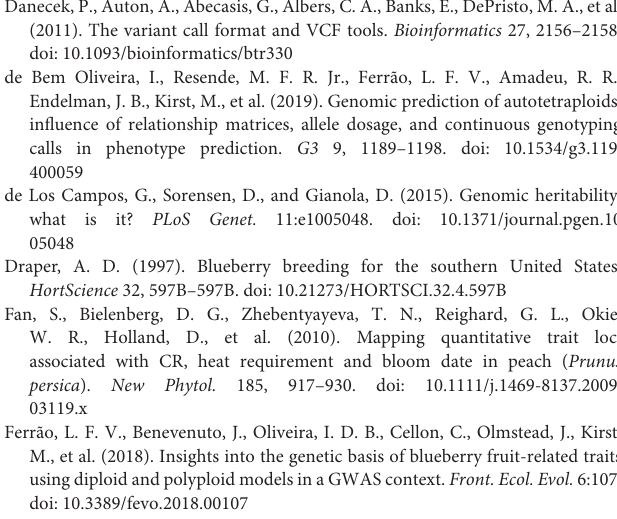
loci with the lowest value of p . Double asterisk ( ∗∗ ) represents the significant difference ( p < 0.01). Supplementary Figure 6 | Characterization of the associations with flowering date detected on chromosome 7. (A,B) Associations with the flowering date. (A) GWAS for the flowering date in (A) 2019 and (B) 2020 detected by GWASpoly reference duplex dominant model with SNP discrete genotype call. Red dots represent significant phenotype-genotype associations (FDR < 0.1). (C,D) Comparison of flowering date in (C) 2019 and (D) 2020 based on the genotypes at Chr7: 10849491. (E) Comparison of flowering date in 2018 based on the genotypes at Chr7: 10849505. Asterisks (*, **, and ***) represents the significant difference ( p < 0.05, p < 0.01, p < 0.001), respectively. (F) Pairwise allelic genotype correlation plot of Chr7: 10849491. Red and glean dots represent loci significantly associated with the flowering date in 2019 and 2020, and with flowering date in 2018, respectively. Red and green lines represent a cubic spline fitted for the 95th and 50th percentiles, respectively. Supplementary Figure 7 | Manhattan plot for FDP in 2019 season. GWAS results detected by GWASpoly reference duplex dominant model with SNP discrete genotype call. The red dot represents significant phenotype-genotype associations (FDR < 0.1). Supplementary Figure 8 | Differences of allele frequencies at loci significantly associated with phenology traits between NHB and SHB. Proportions of cultivar group at loci significantly associated with (A) flowering date in 2019 and 2020 (Chr3: 4052918), (B) continuous flowering (Chr5: 18699641), (C) flowering date in 2019 and 2020 (Chr7: 10849491), (D) FDP in 2018 (Chr9: 8401122), and (E) flowering date in 2018 (Chr9: 8490641). Supplementary Figure 9 | Differences of phenology-related allele frequencies among breeding locations. The proportion of genotype at loci significantly associated with (A) flowering date in 2019 and 2020 (Chr3: 4052918), (B) continuous flowering (Chr5: 18699641), and (C) flowering date in 2018 (Chr9: 8490641). Supplementary Figure 10 | Comparison of the putative ancestral genome proportions based on the genotypes at the GWAS peaks. (A) Comparison of fraction of the subpopulation 6 with or without late-flowering allele at Chr3: 31244833. (B) Comparison of fraction of the subpopulation 4 with or without low-chill allele at Chr4: 36498180. (C) Comparison of fraction of the subpopulation 1 with or without late-ripening allele at Chr7: 10064365. Asterisks ( ∗ , ∗∗ , and ∗∗∗ ) represents the significant difference ( p < 0.05, p < 0.01, p < 0.001), respectively. Supplementary Table 1 | List of accessions used in this study. Circles in the genome-wide association study (GWAS) column represented accessions employed in